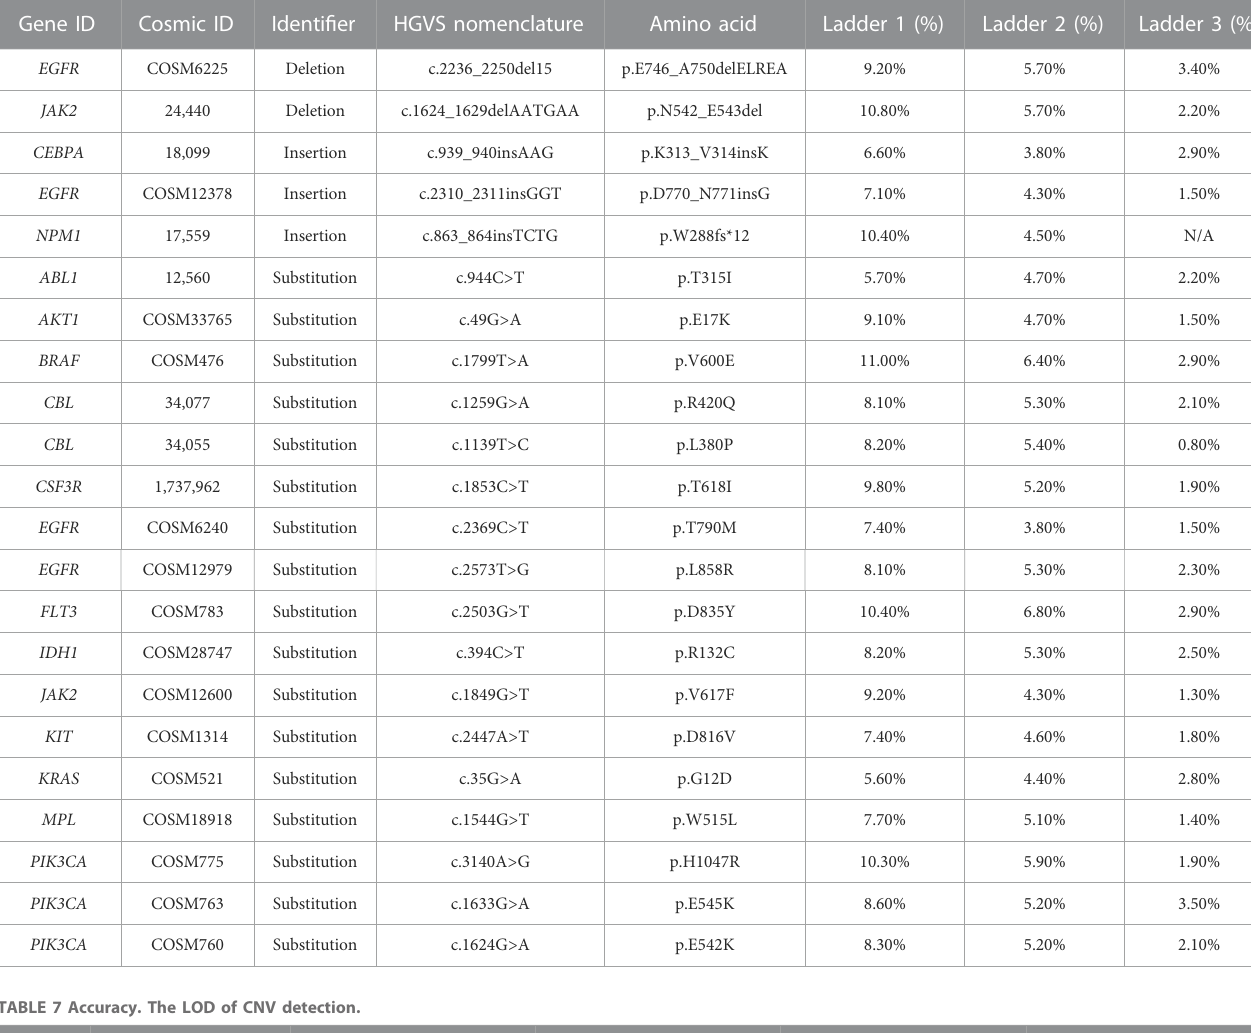
TABLE 6 Accuracy. The LOD of variant AF (SNVs and INDELs).